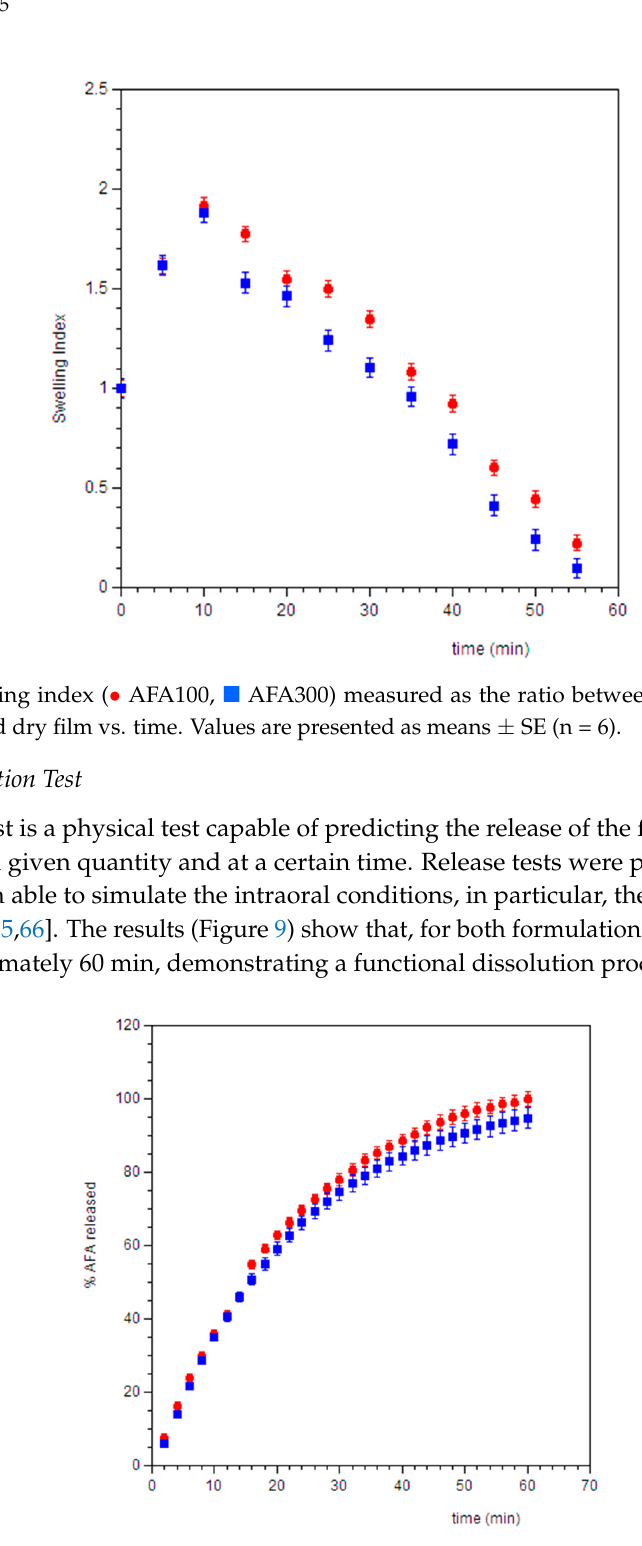
Figure 9. Cumulative percent of AFA released from film disks ( • AFA100, (cid:4) AFA300) in simulated saliva pH 6.8. Values are presented as means ± SD (n = 6).